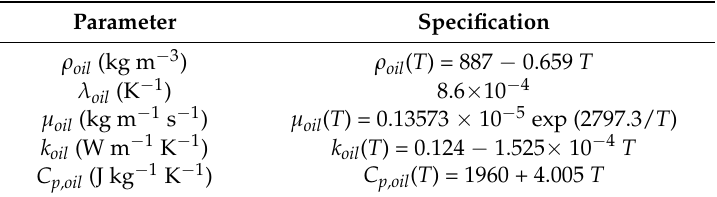
Table 2. Thermal Parameters of Mineral